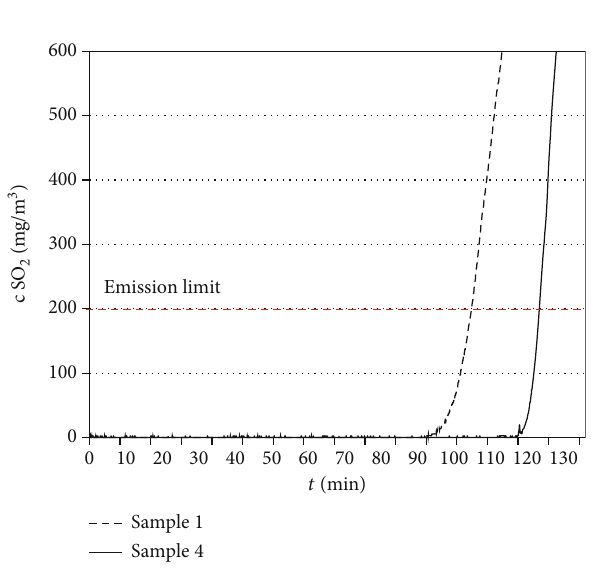
Figure 2: The breakthrough curves of samples 1 and 4.